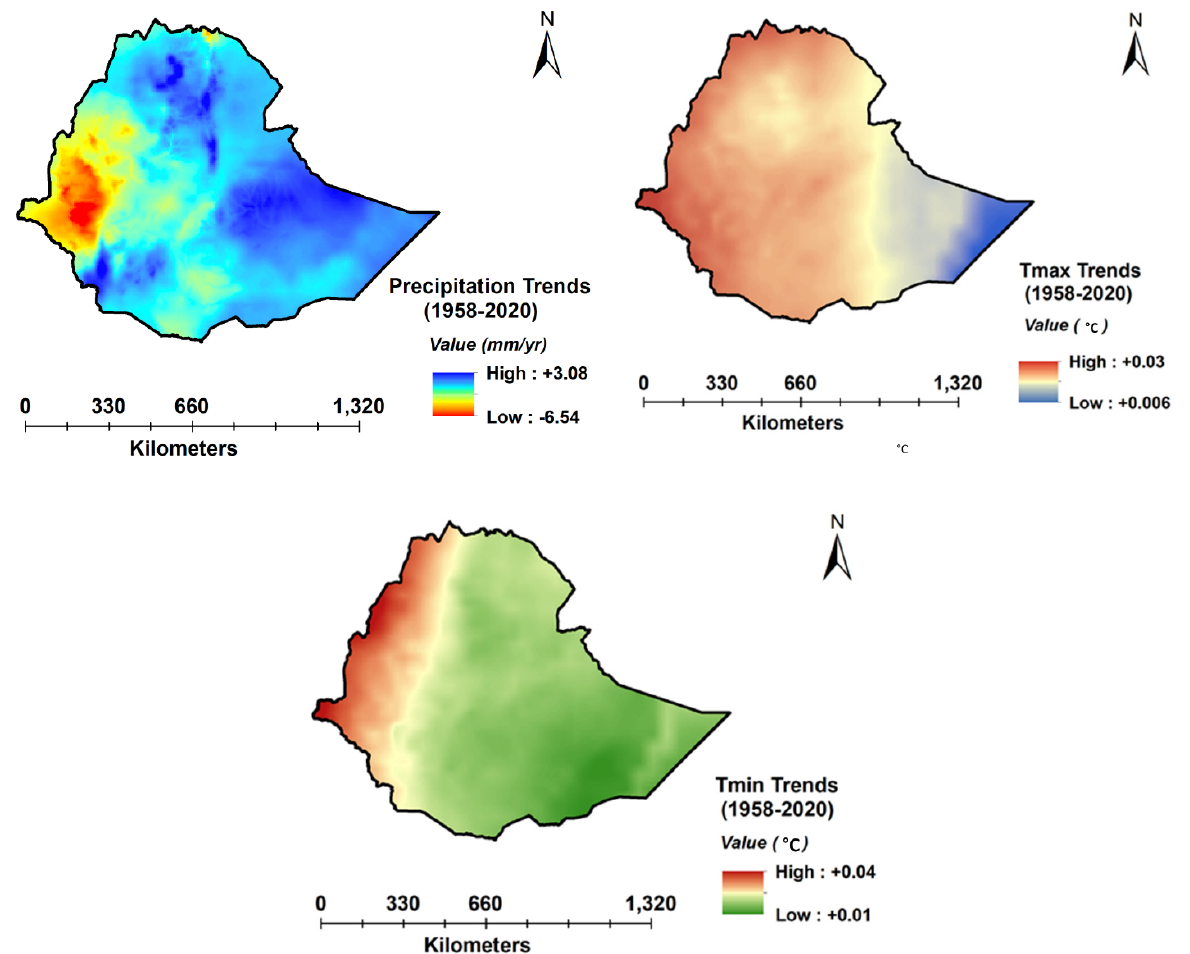
Figure 3. Spatial distribution of the precipitation, maximum and minimum temperature trend (slope of the linear regression) map for 1958–2020 in the study of Ethiopia.